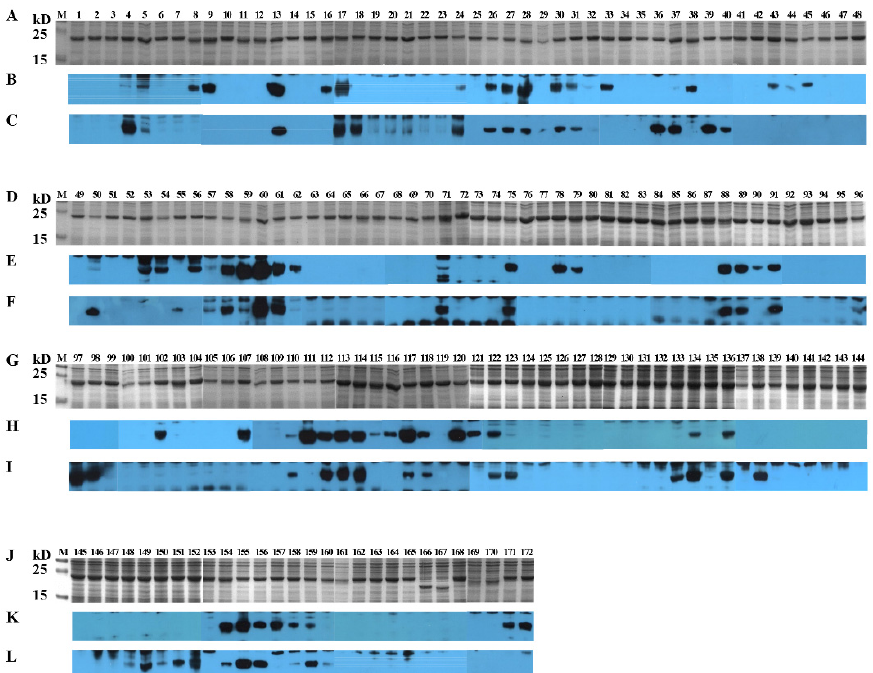
Figure 5. SDS-PAGE and Western blotting analysis of 16-mer- and 14-mer S CV777 -derived peptides. One hundred and seventy-one 16-mer peptides and one 14-mer peptide covering the entire S CV777 were glutathione S-transferase (the initial 188 aa, GST)-fusion expressed in Escherichia coli ( E. coli ) BL21. After induction, cells were harvested by centrifugation, and cell pellets were resolved by SAS-PAGE using 15% gels. Gels were either stained or processed for Western blots. Polyvinylidene difluoride (PVDF) membranes were first blocked with 5% ( w / v ) skimmed milk, incubated sequentially with anti-S serum and goat anti-rabbit IgG, and then visualized by enhance chemiluminescence. ( A , D , G , J ): SDS-PAGE analysis of 171 GST-fusion expressed 16-mers and one 14-mer. ( B , E , H , K ): Western blot analysis of 171 GST-fusion expressed 16-mers and one 14-mer with anti-S CV777 serum. ( C , F , I , L ): Western blot analysis of 171 GST-fusion expressed 16-mers and one 14-mer with anti-S SD2014 serum. 1–172: GST-fusion expressed 16-mers (P1–P171) and 14-mer